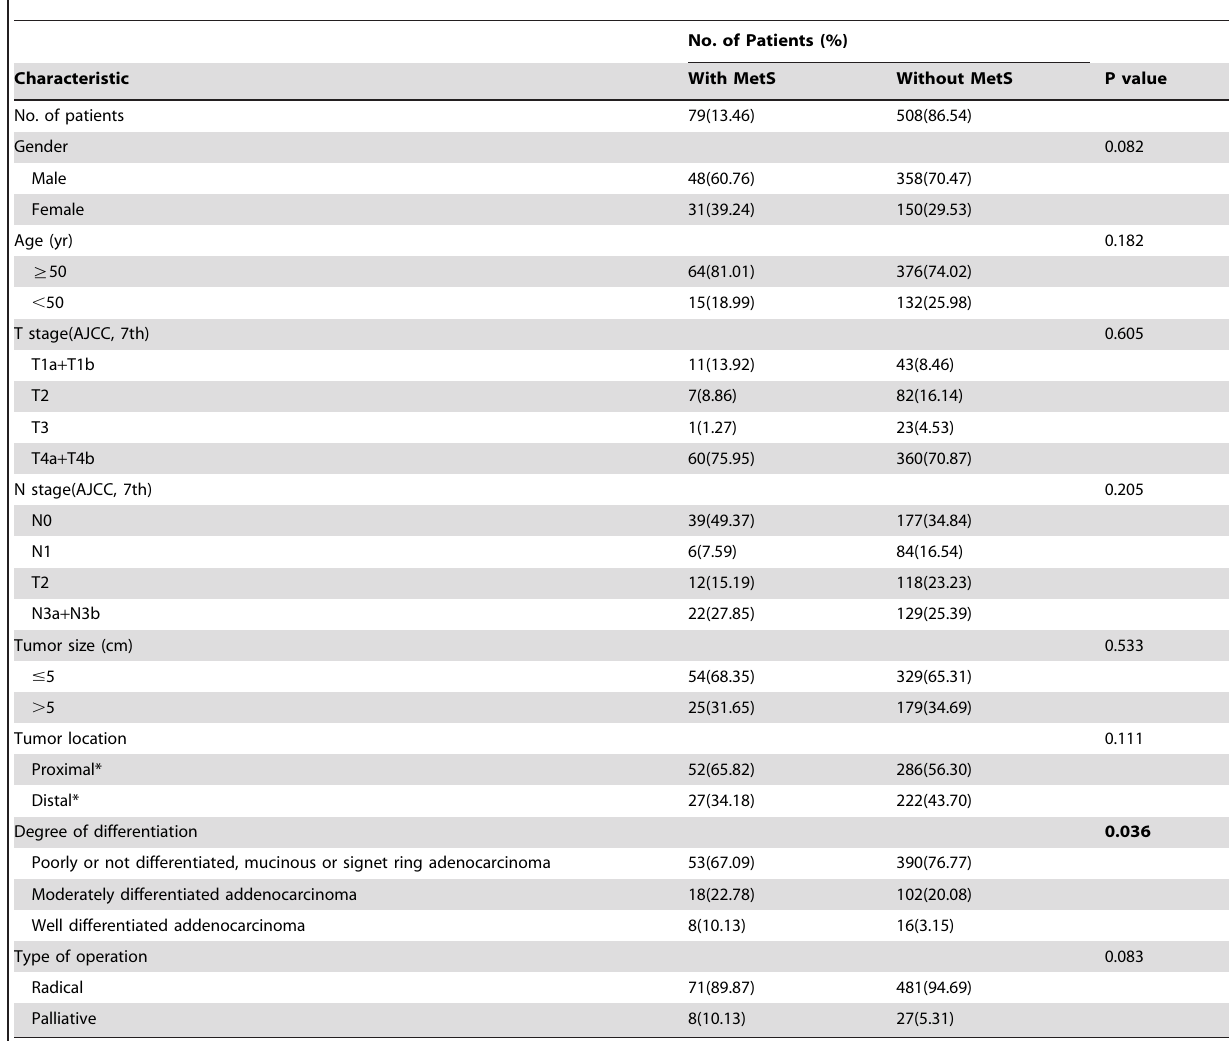
Table 1. Comparison of baseline clinical characteristics According to Metabolic Syndrome